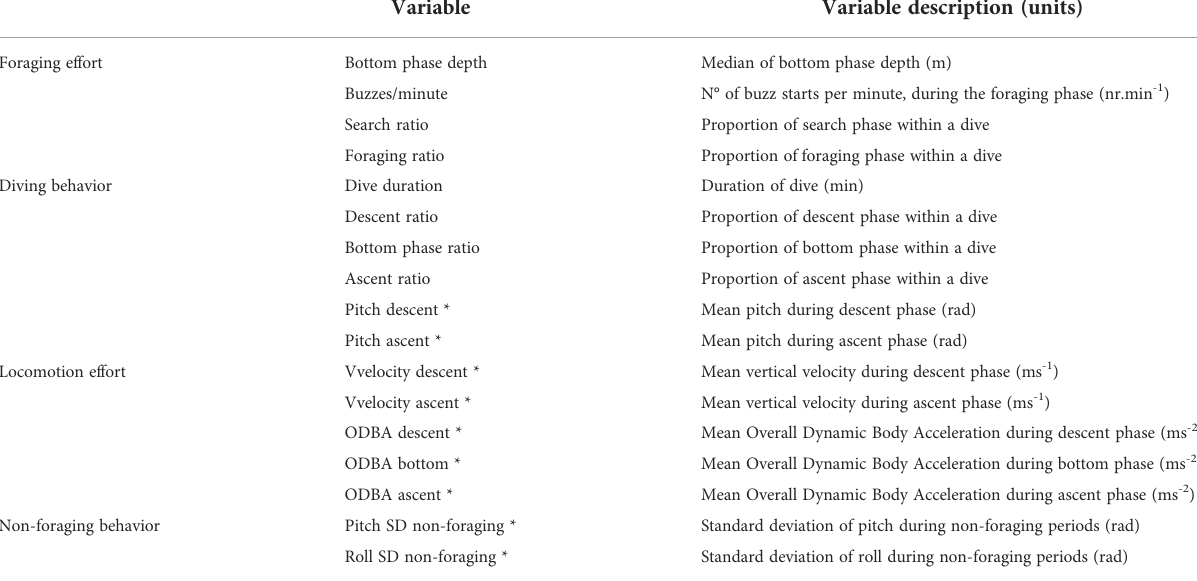
TABLE 1 Hypotheses, variable names and variable descriptions used in the analysis of the effects of whale watching vessels on sperm